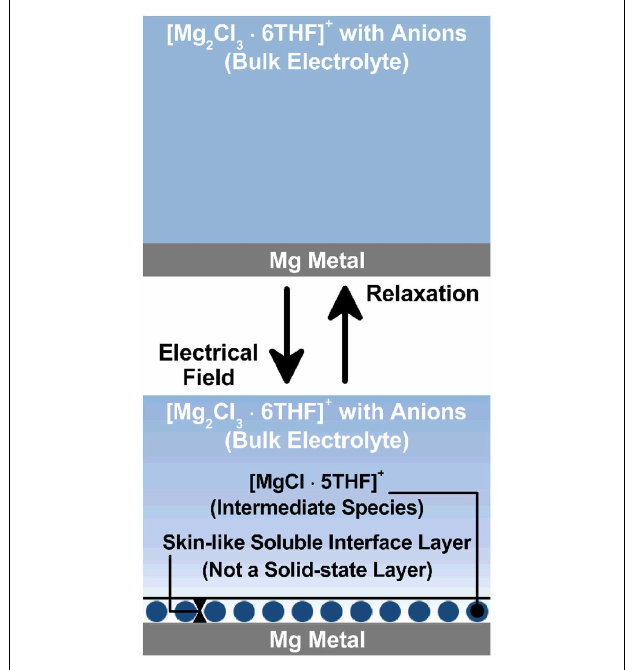
FIGURE 10 |A schematic image of the Mg metal/organohaloaluminate electrolyte interface layer incorporating intermediate species